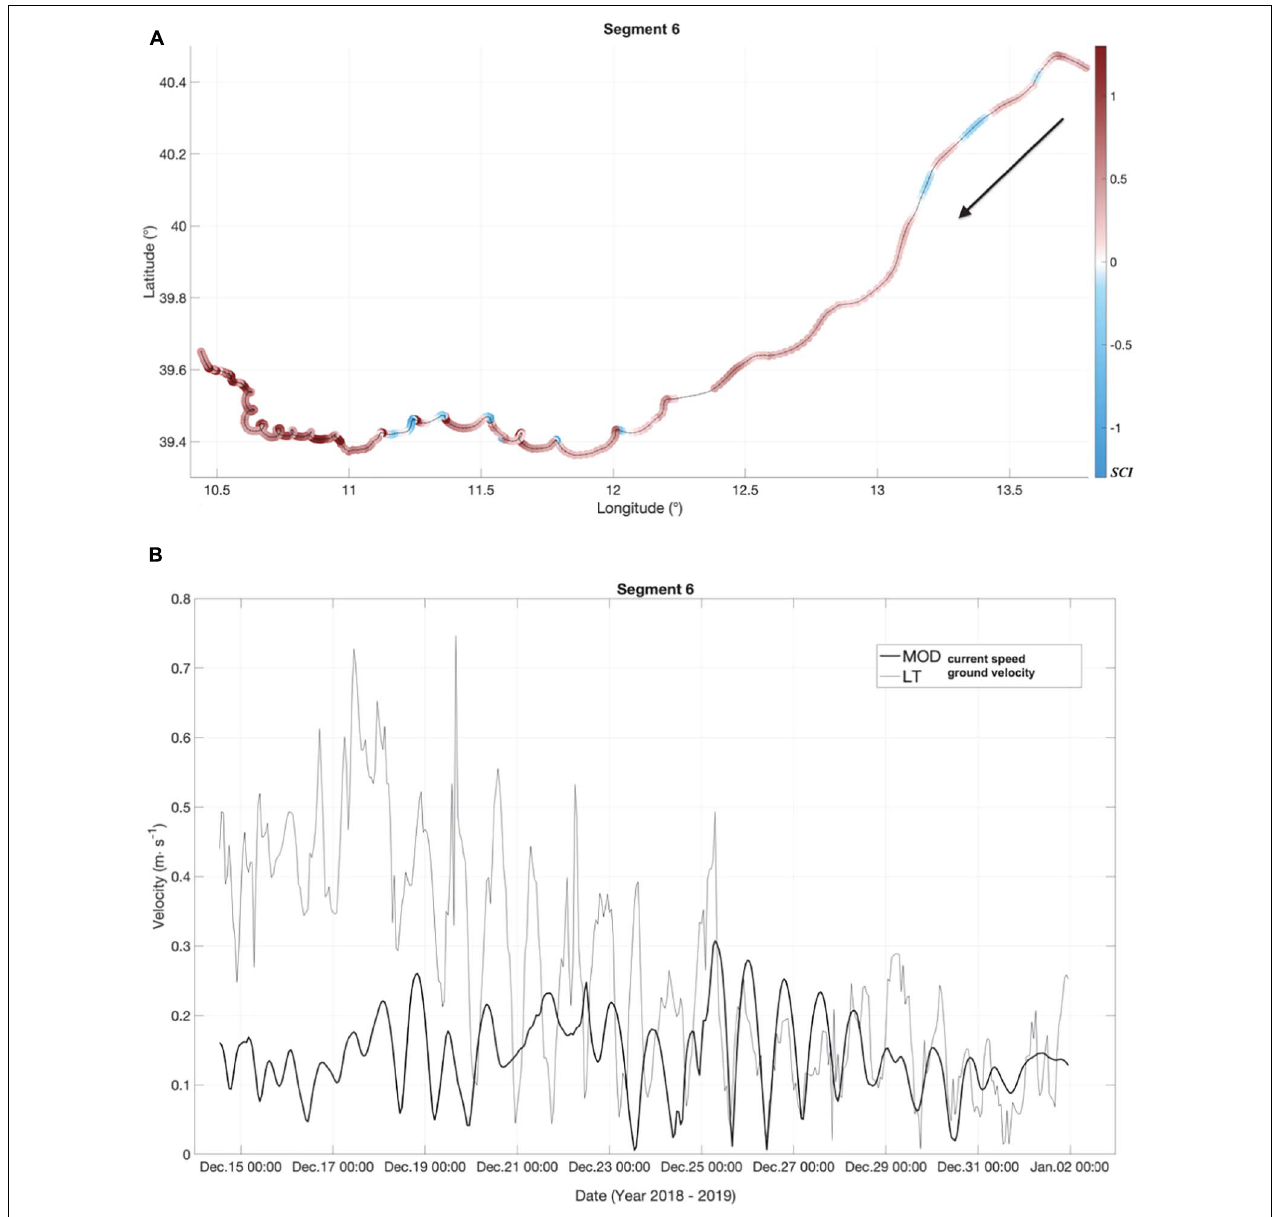
FIGURE 8 | (A) Segment 6 of the loggerhead turtle (LT) trajectory (black line; Figure 4 ) with SCI values at sampling points. The black arrow indicates the general direction of the motion along this segment. (B) Intensity of the LT ground velocity (thin gray line) and MOD sea current velocity (thick black line) along this Segment.